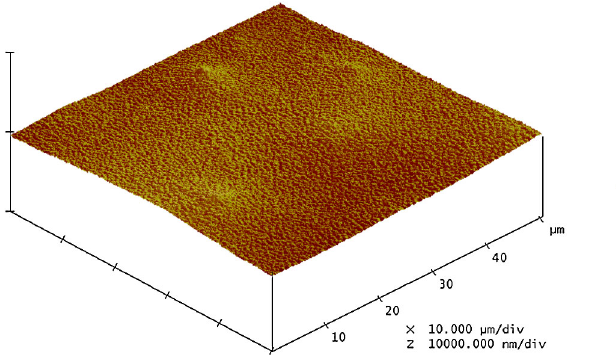
FIG. 10. AFM scan ( 50 (cid:1) m (cid:1) 50 (cid:1) m ) of surface prepared by plasma